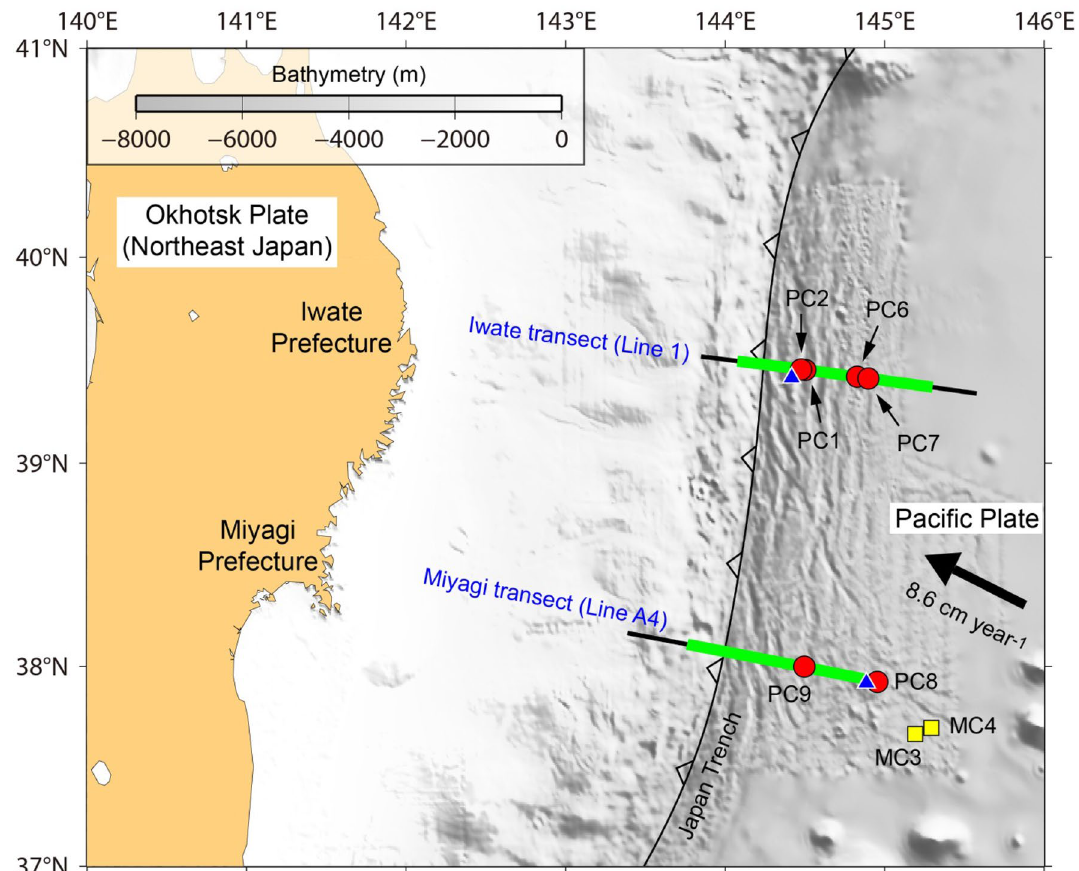
Figure 1. Bathymetry map of the Japan trench margin offshore NE Japan. The Pacific plate subducts beneath the Okhotsk plate (NE Japan) at a convergence rate of 8.6 cm year −1 (ref. 20 ). Heavy green lines mark MCS profiles depicted in Fig. 3, which are on the two lines of A4 (Miyagi transect) and 1 (Iwate transect). Six red circles (PC1 to PC9) on the two MCS lines indicate the gravity coring sites. Two yellow squares (MC3 and MC4) indicate the bottom seawater sampling sites. Two blue triangles mark petit-spot volcanoes 21,22 nearest from lines A4 and 1,